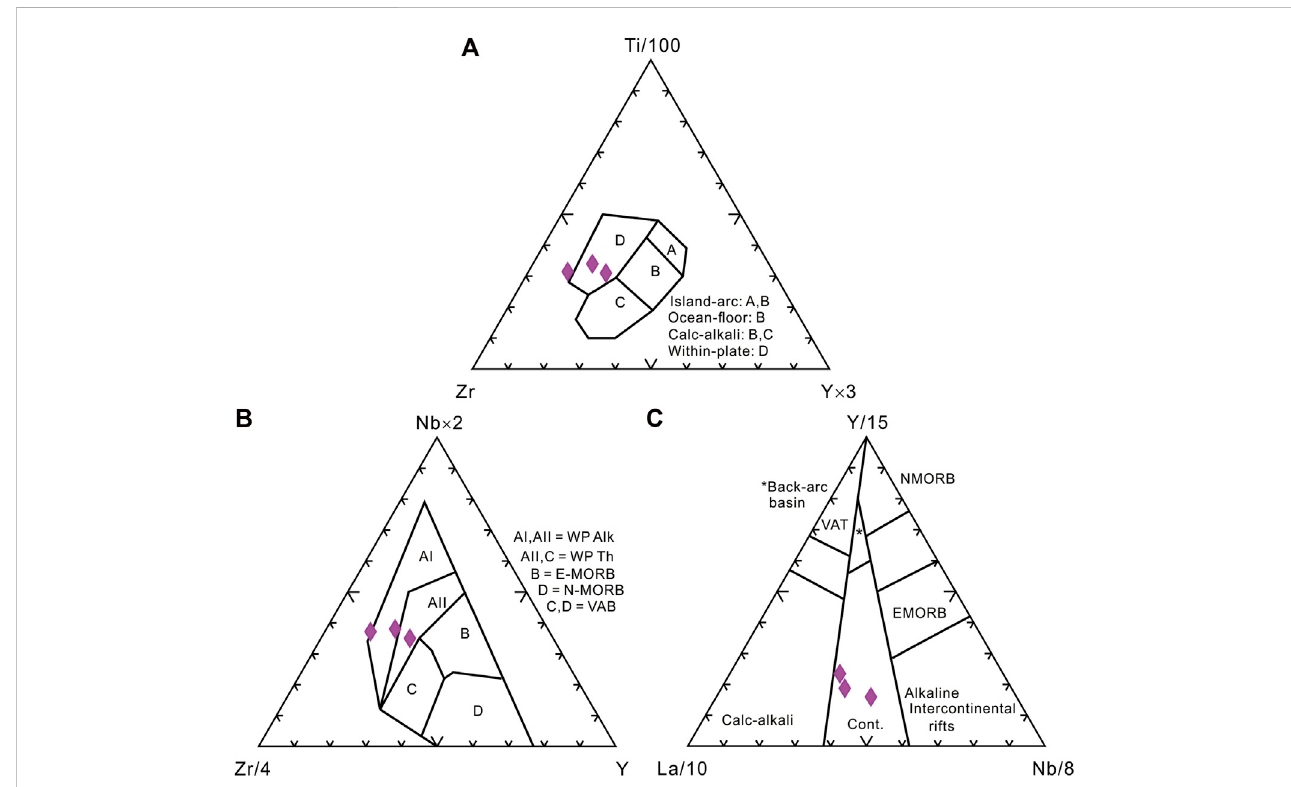
FIGURE 11 Tectonomagmatic discrimination of the basaltic rocks using the schemes of (A) Pearce and Cann (1973), (B) Meschede (1986), and (C) Cabanis and Lecolle (1989). WP Alk = within-plate alkaline basalt; WP Th = within-plate tholeiitic basalt; E-MORB = enriched mid-ocean ridge basalt; N-MORB = normal mid-ocean ridge basalt; VAB = volcanic-arc basalt; VAT = volcanic-arc